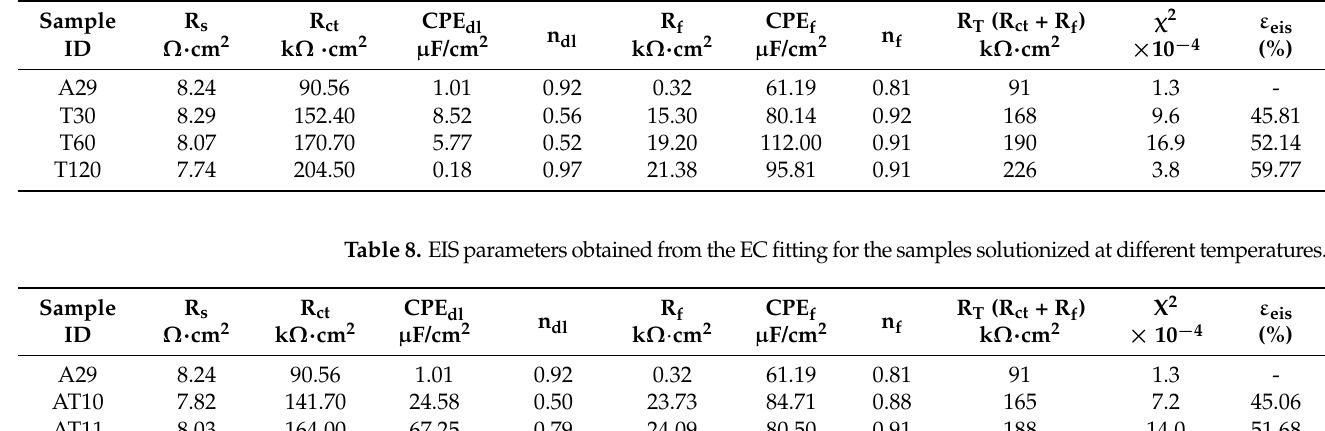
Table 7. EIS parameters obtained from the EC fitting for the samples solutionized for different durations.